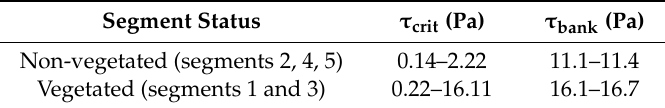
Table 7. Range of critical shear stress for erosion, τ crit , obtained with the cohesive strength meter (CSM) and estimated range of the hydraulic shear stresses acting on the banks, τ bank , obtained using Equation